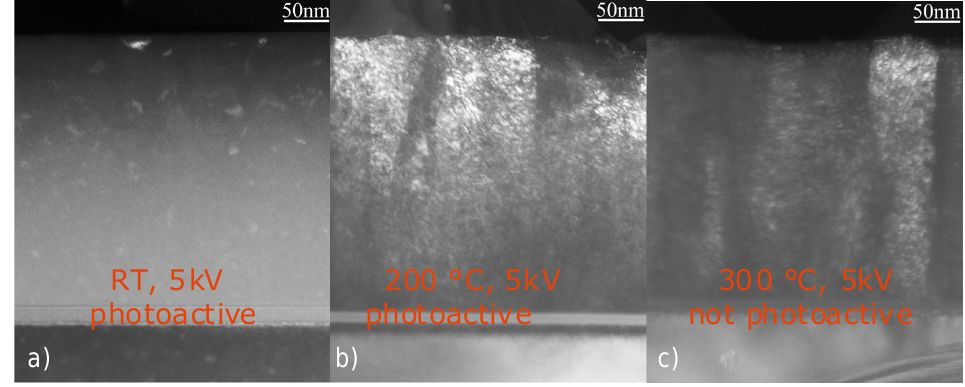
Figure 15 . Transmission electron microscopy (TEM) dark field viewgraphs of three different samples, deposited at 5 kV pulse voltage at (a) room temperature, (b) 200 °C and (c) 300